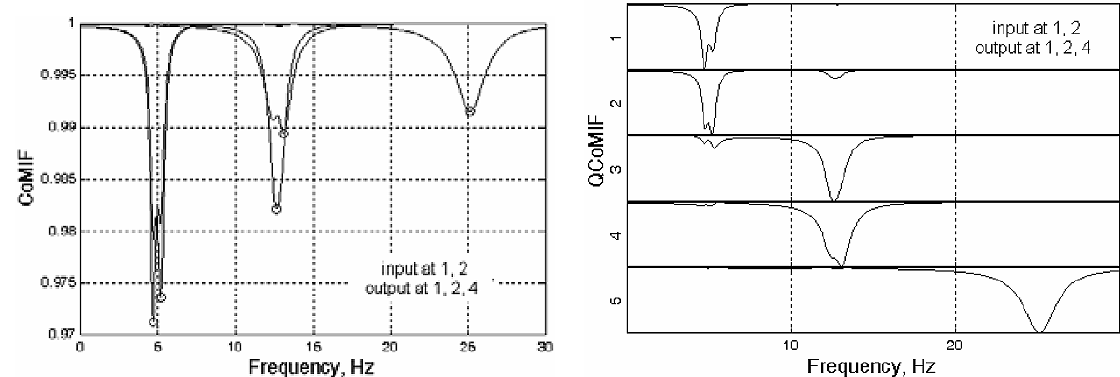
Fig. 10. CoMIF for the 5-dof system. Fig. 11. QCoMIF for the 5-dof